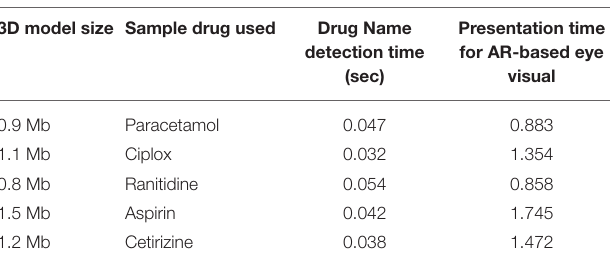
TABLE 4 | Response time-based